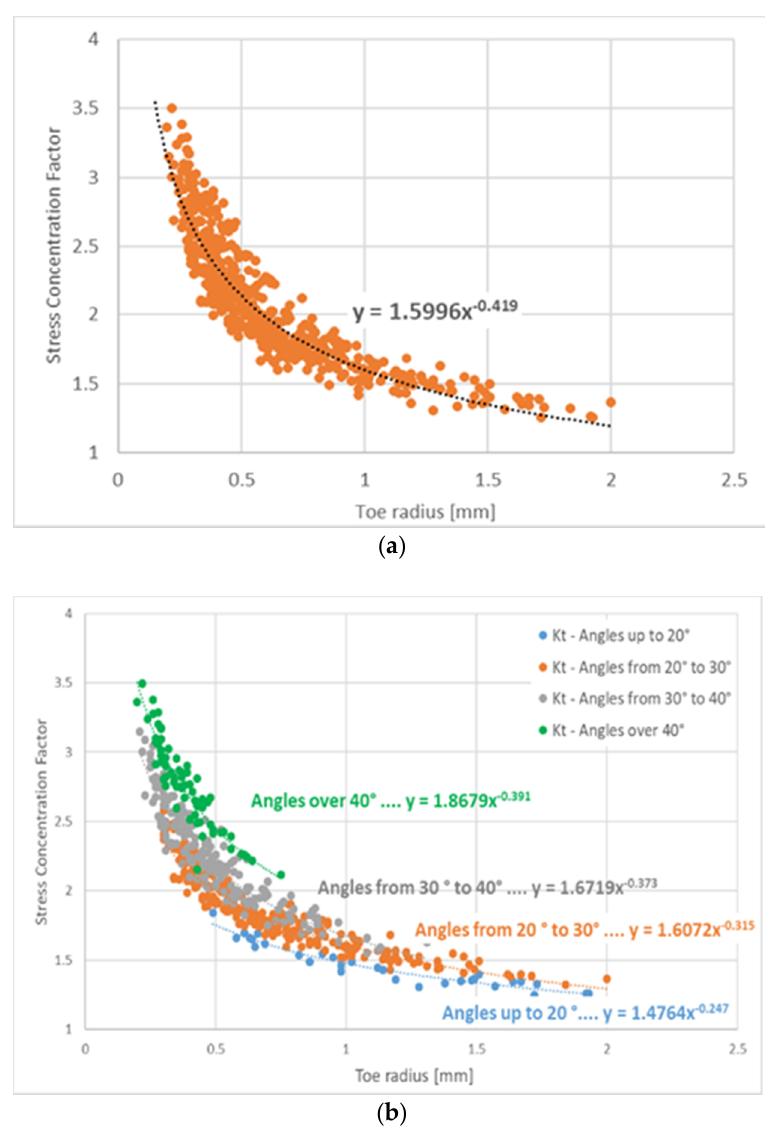
Figure 3. ( a ) SCF with respect to toe radius; ( b ) SCF with respect to the toe radius depend on the weld toe angle for different values.